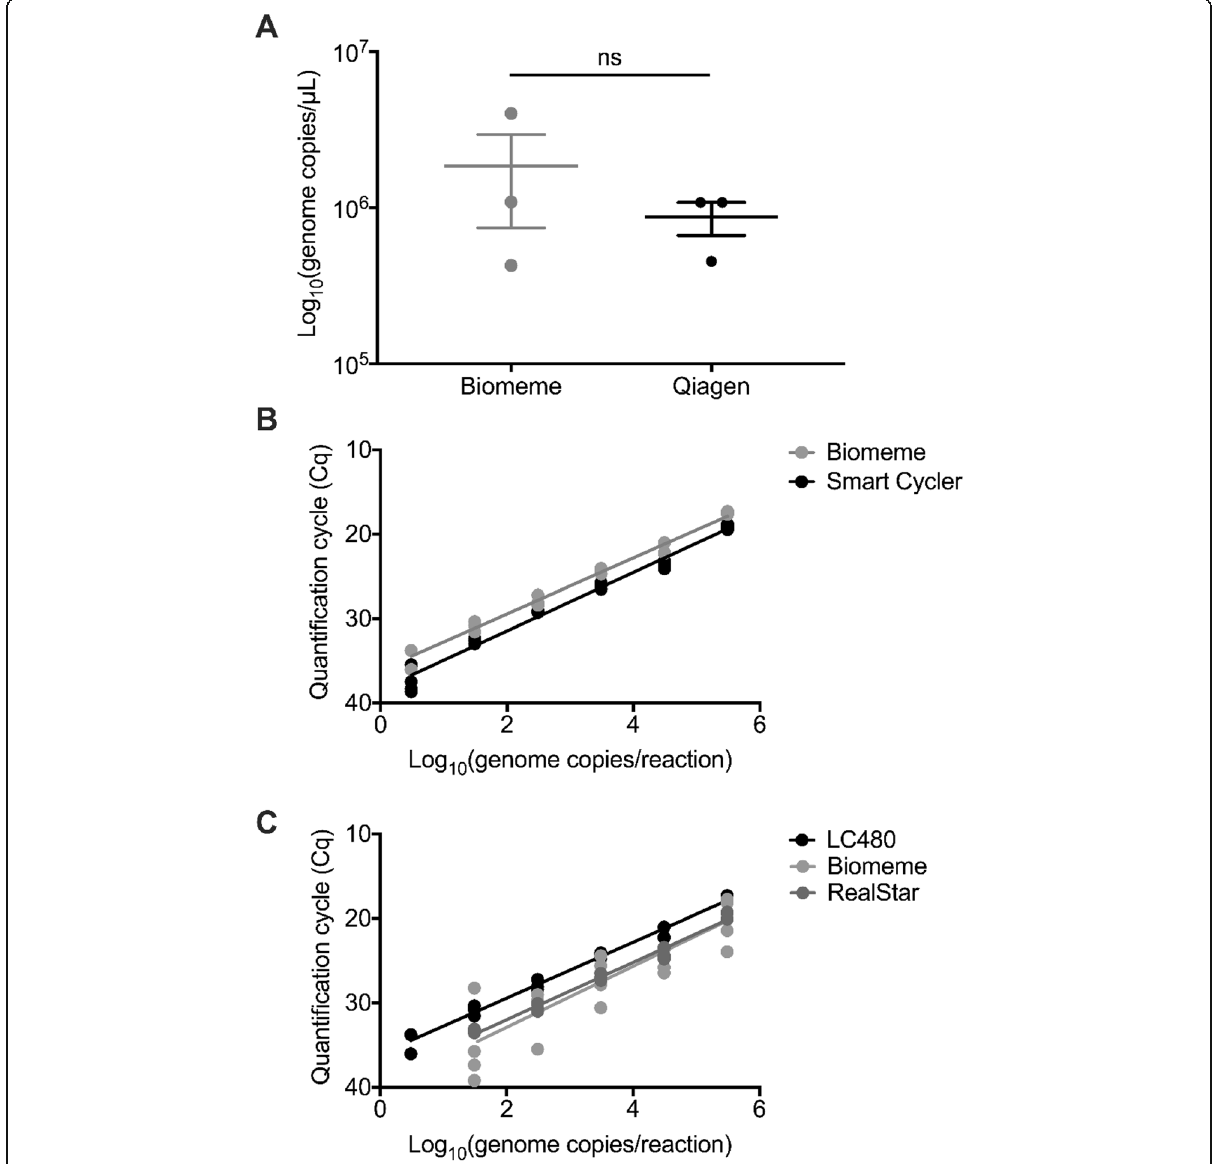
Fig. 1 Validation of the PoE platform and assay. a Comparison of the efficiency of extraction of Ebola virus stocks H.sapiens-tc/COD/1995/Kikwit- 15476 (EBOV/Kik) between the M1 Sample Prep or the Qiagen Viral RNA kit. The amount of RNA extracted by the two methods was not statistically different (Mann-Whitney test p > 0.05). Displayed are the three individual replicates for each extraction including mean and standard error of the mean. b Comparison of the Biomeme Franklin Three9 Real-Time PCR Thermocycler (BM) and the Smart Cycler using a ten-fold dilution series of EBOV/Kik, extracted using the Biomeme M1 Sample Prep, and measured using Roche LightCycler 480 RNA Master Hydrolysis Probes. c Comparison of the Biomeme lyophilized reagent system with the Roche LightCycler 480 RNA Master Hydrolysis Probes reagents and the Altona RealStar Ebola virus RT-PCR kit. A ten-fold dilution series was analyzed using the three reagent systems on the BM. The results of each individual replicate are depicted in the graphs. Genome copies/ μ L were calculated using a linear regression model derived from a tenfold dilution series analyzed with Droplet Digital